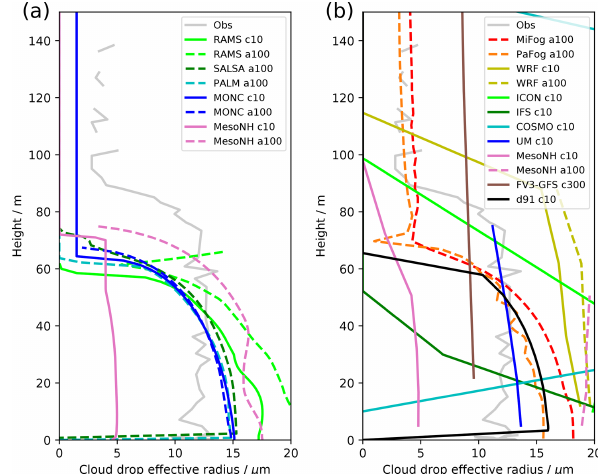
Figure 3. Effective radius observed and simulated by the low aerosol/CDNC (a) LES and (b) SCMs at 00:00UTC.